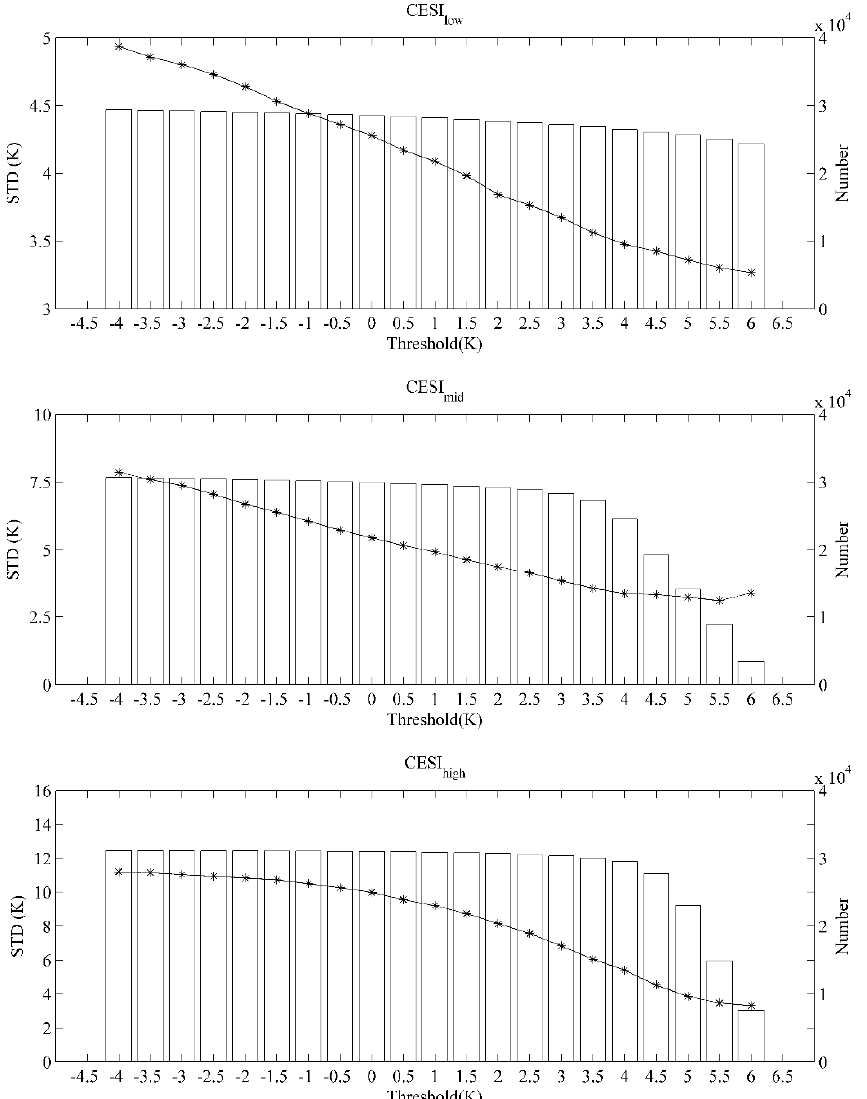
Figure 14. The standard deviation of O − B values (lines with asterisks) and the remaining number (bars) of MWHS channel 10 (150 GHz) in the clear sky region over ocean surface. The clear-sky points are screened out by the corresponding threshold.